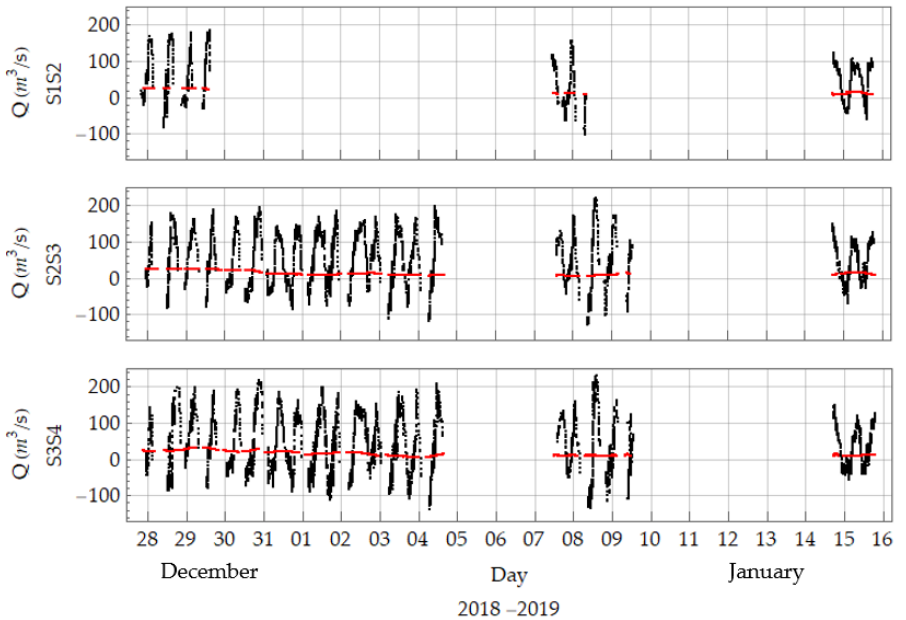
Figure 5. Temporal variations in water discharge (black) and residual flow (red) estimated using FAT at the selected stations during the study period.